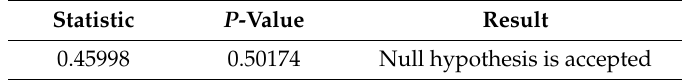
Table 10. Homocedasticity test of FPBST and DT+ accuracies obtained from Table 8.